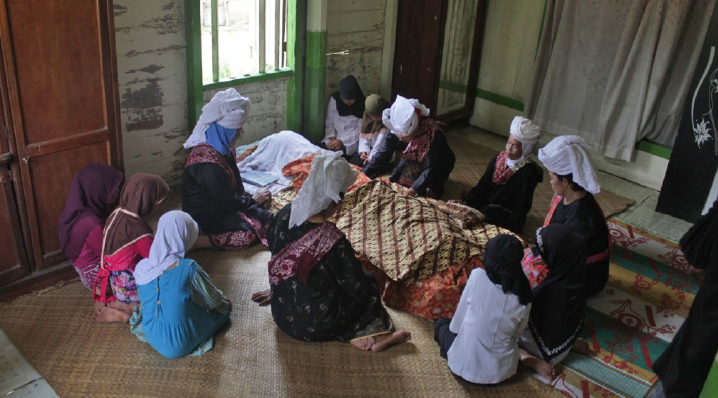
Figure 2. Bewailing on house roof (source: created by authors)